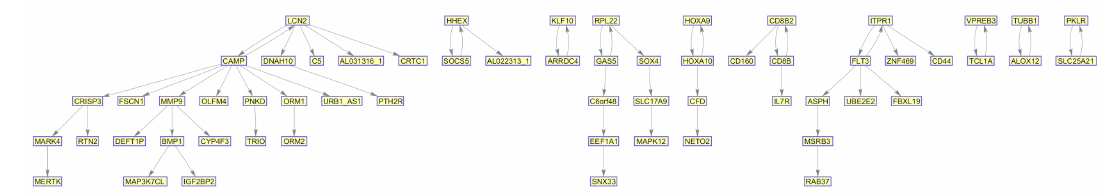
Figure 8. GRN generated from the application of MIDER on the acute myeloid leukaemia (AML)